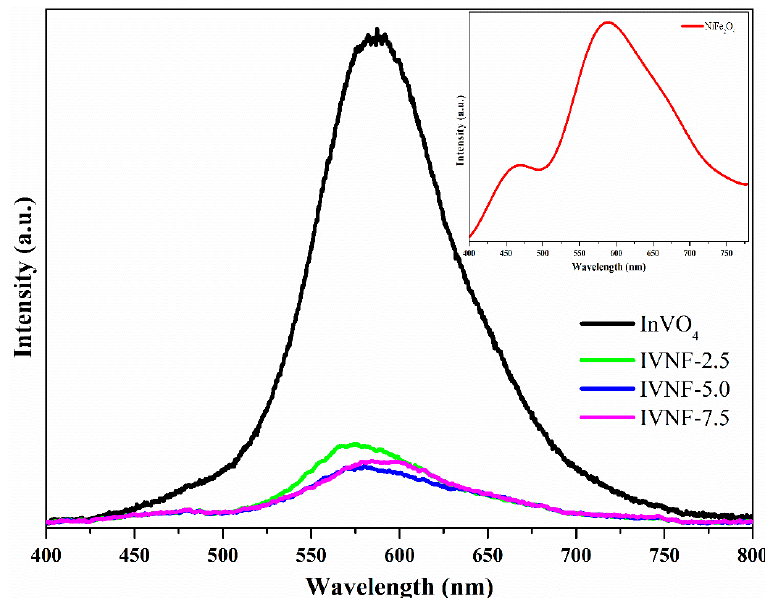
Figure 7. Photoluminescence spectra of the as-prepared samples.